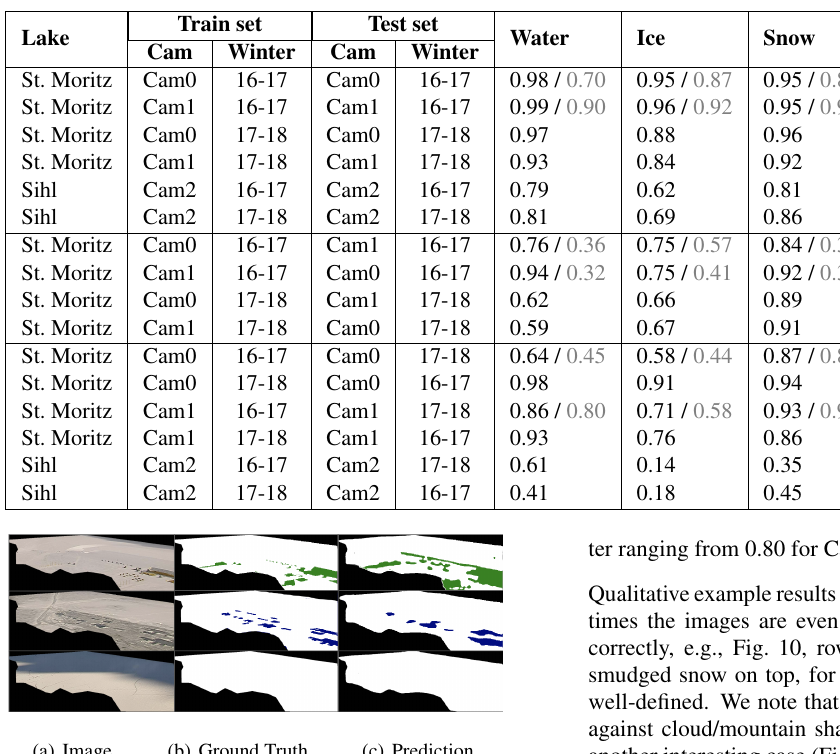
Figure 9: Deeplab v3+ vs. Deep-U-lab . Segmentation boundaries are visibly crisper and more accurate with additional skip connections. Table 3: Lake ice segmentation results (IoU) on the Photi-LakeIce dataset. For comparison, we also show results of Tom et al. (2019) where available, in grey. We outperform them in all instances.